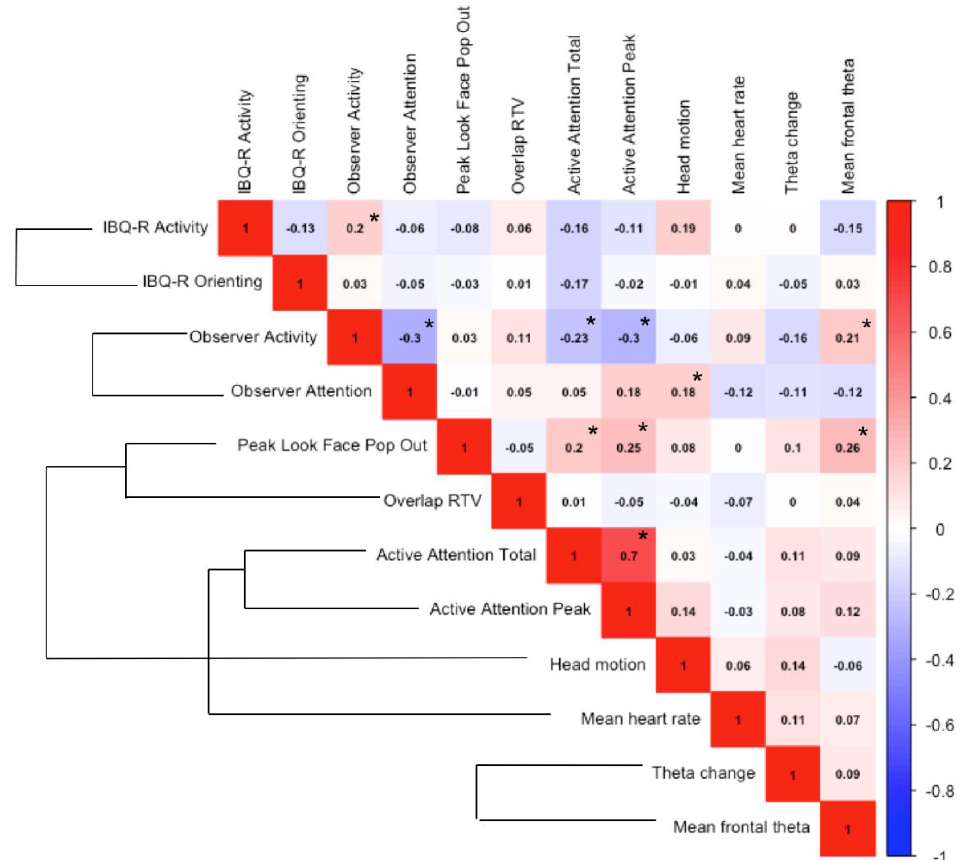
Figure 2. Correlation matrix heatmap of measures of infant attention and activity level for the full sample at 10 months. External brackets indicate that the two measures come from the same testing domain (e.g., the same EEG or eye-tracking testing session). Spearman r values are shown. Significant correlations (* p < 0.05) are denoted by an asterisk. Given the exploratory nature of this analysis, p -values were not corrected for multiple testing.